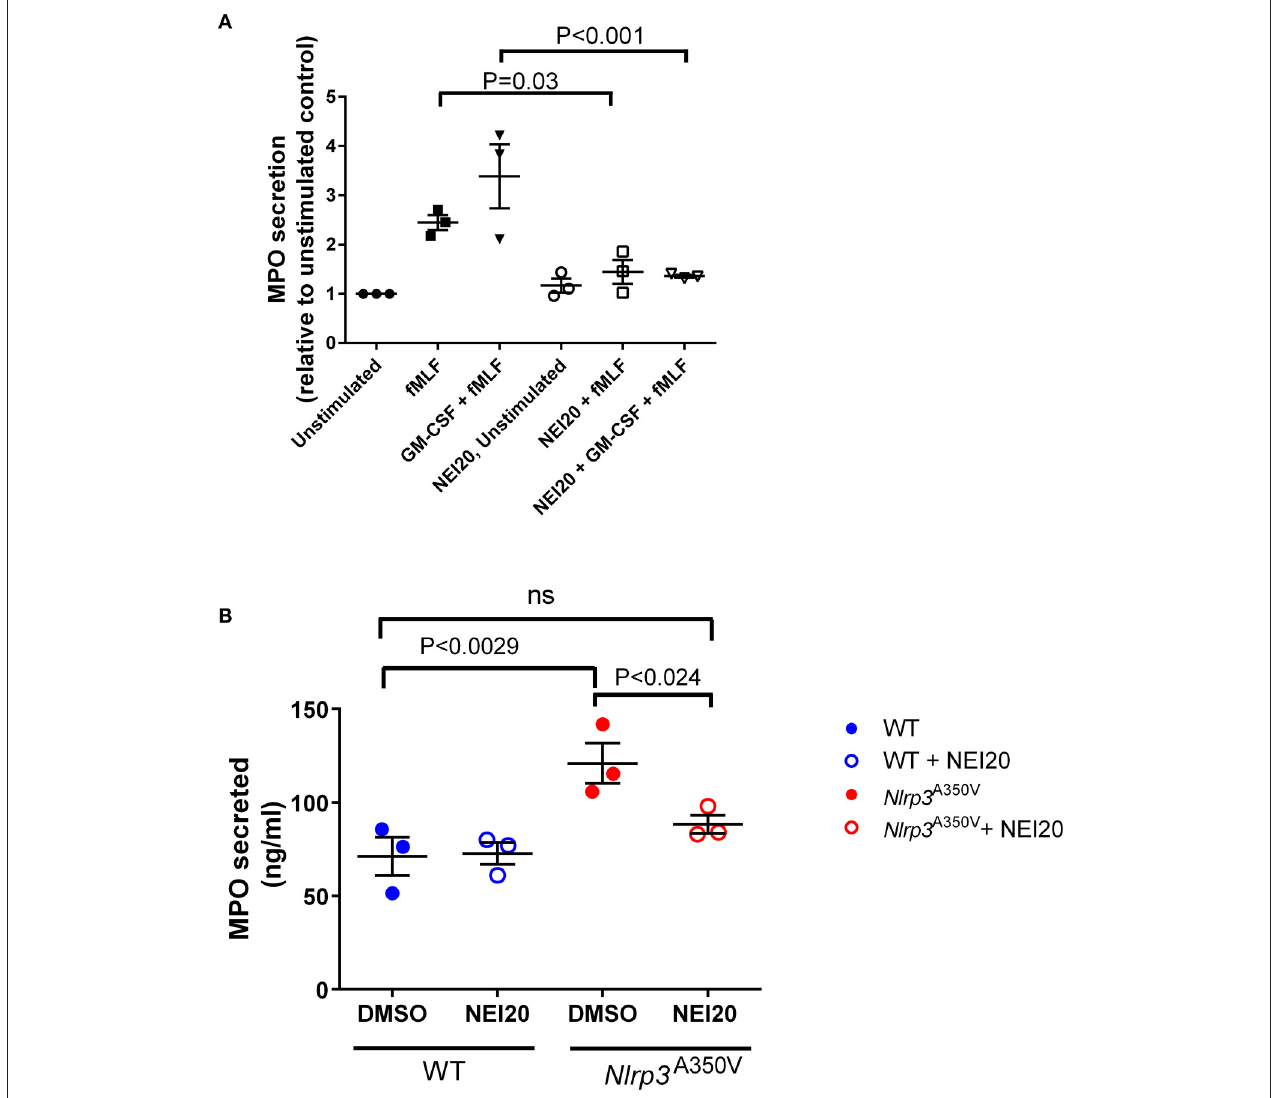
FIGURE 6 | Functional analyses identify Nexinhib20 as an efficient inhibitor of azurophilic granule exocytosis in Nlrp3 A350V MWS neutrophils. The mobilization of azurophilic granules by wild type or Nlrp3 A350V MWS neutrophils was analyzed by monitoring the secretion of myeloperoxidase (MPO) by ELISA as described under “Materials and Methods.” (A) Wild type neutrophils were incubated in the presence of Nexinhib20 (NEI20) at 10 µ M or DMSO and subsequently stimulated with fMLF, GM-CSF + fMLF or left unstimulated. (B) Unstimulated wild type or Nlrp3A350V MWS neutrophils were treated with Nexinhib20 and MPO secretion was determined as above. The data is represented as mean ± SEM ( n = 3). Significant differences between groups were calculated using ANOVA followed by Fisher’s post-hoc test. ns, not